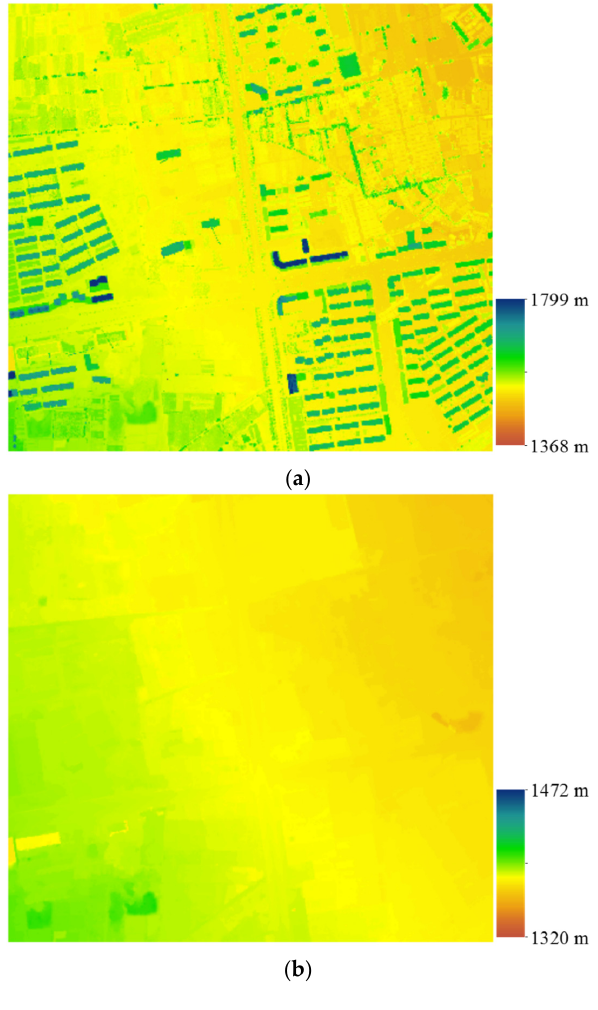
Figure 2. Cont. Figure 2.